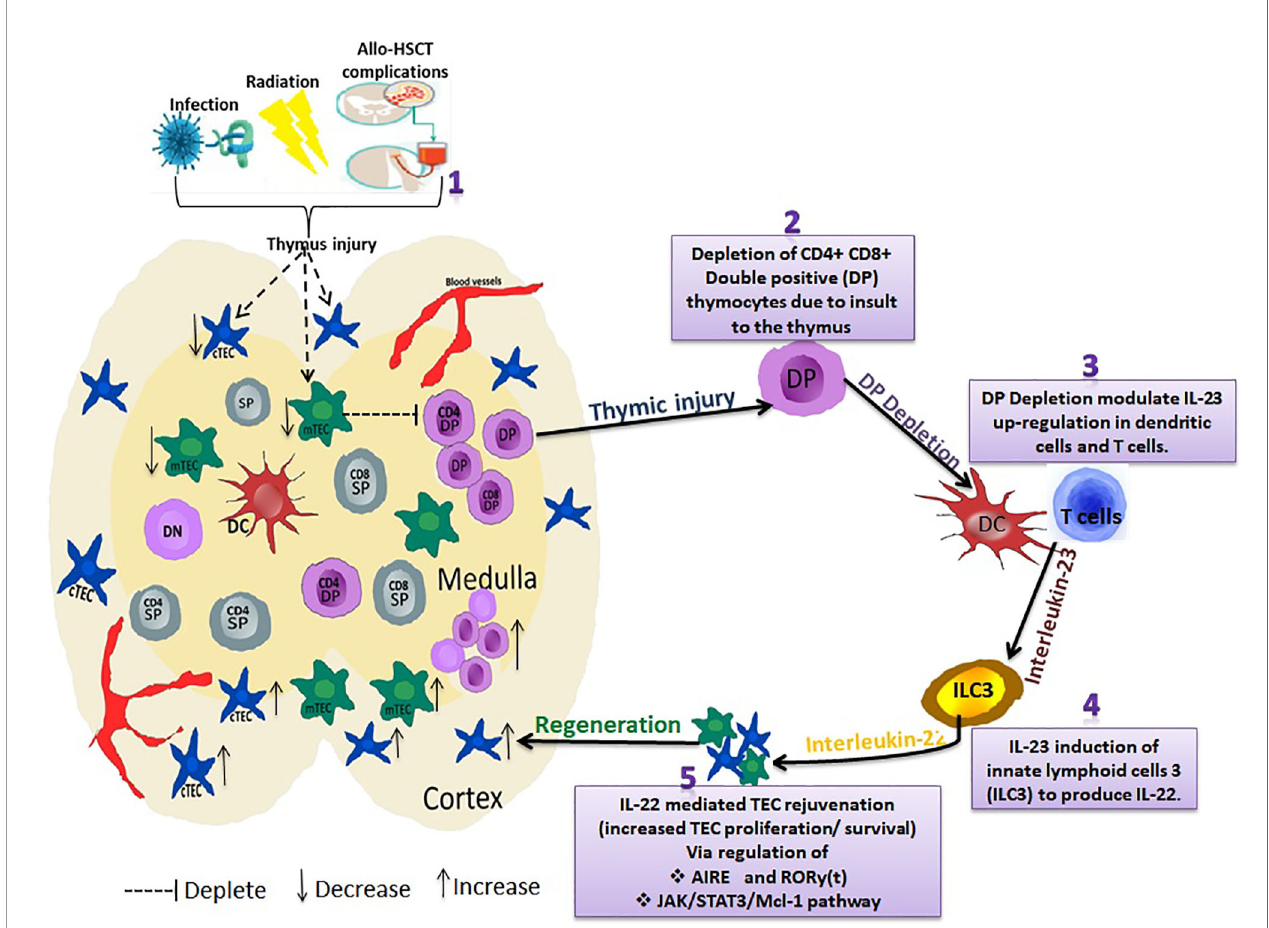
FIGURE 2 | Interleukin-22 promotes endogenous thymic regeneration. Exposing the thymus to infection, irradiation, and Allo-HSCT treatment regime (1) results in depletion of CD4+ CD8+ Double positive (DP) thymocytes (2) DP depletion modulates IL-23 up-regulation in dendritic cells and T cells (3). IL-23 then induces the group 3 innate lymphoid cells (ILC3) to produce IL-22 cytokines (4). IL-22 regulates AIRE and RORy(t) via JAK/STAT3/Mcl-1 pathway (5). This subsequently causes a signi fi cant increase in TEC proliferation/survival, thus boosting TEC and thymus